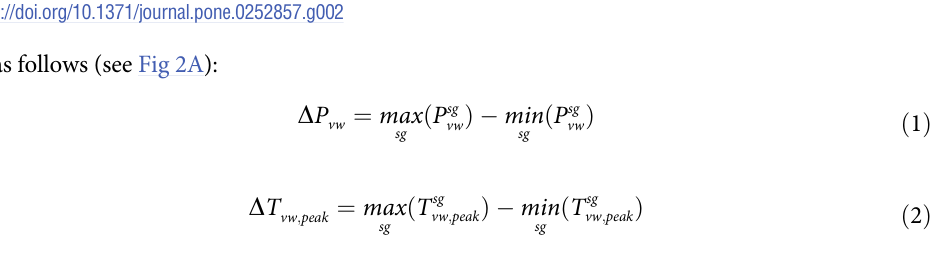
Fig 2. Feature extraction from longitudinal strain time series in an example case of a 4ch view. A) Longitudinal strain signals for all segments, observed from a 4ch view, showing standard amplitude and time-domain features extracted from these signals. Black vertical lines correspond to the manually identified onset of the QRS ( T ) and the aortic valve QRS closure instant ( T 4 ). The color dots correspond to the peak strain value ( P sg ) of each segment, arriving at time T sg . ch , avc 4 ch 4 ch ; peak B) Calculation of three strain integral features from the longitudinal strain signal of segment BL of the 4ch view. C) Identification of the different segments on the 4ch view, showing how the sum of integrals for different segments are calculated (B: basal, M: Mid, and A: Apical, S: Septal and L: Lateral). Note that corresponding colors for each segment were used for panels A and C but these colors are different from those used in Fig